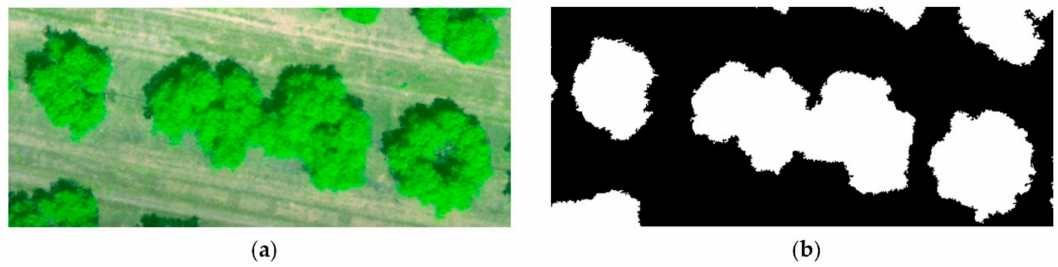
Figure 10. ( a ) Sub-image of the study plot orthomosaic represented in Figure 4, where it can be observed a couple of trees with overlapping foliage; ( b ) sub-image of the binary image resulted from the segmentation performed, I BIN def , corresponding to the area represented in ( a ). Note how the two olive trees share the same connected